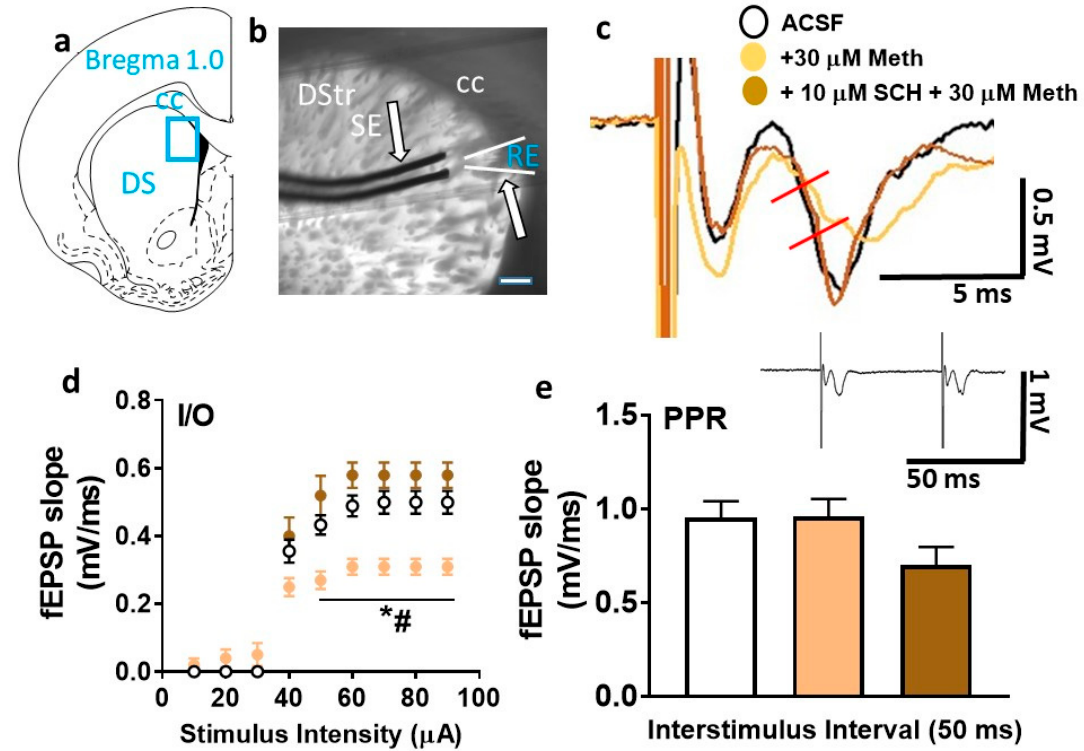
Figure 5. Basal synaptic transmission is reduced by superfusion of methamphetamine in the dorsal striatum. ( a ) Schematic of a coronal slice representing the area of the dorsomedial striatum in blue rectangular box used for stimulation and recordings. ( b ) Infrared microphotograph of a 440- µ m-thick corticostriatal slice from one adult male rat indicating the location of the stimulating electrode (SE) and recording electrode (RE). The scale bar in ( b ) is 100 µ m. Thick arrows point to the electrodes. CC: corpus callosum; DStr: dorsal striatum. ( c ) A representative field excitatory postsynaptic potential (fEPSP) waveform illustrating the parameter computed in the study, including fEPSP slope (measured between the two red lines) from control- (black trace), methamphetamine- (beige trace), and SCH23390 + methamphetamine-treated (brown trace) slices. ( d ) Input / output (I / O) curve obtained by plotting the slope of fEPSPs as a function of the stimulation intensity (from 10 to 90 µ A) in the dorsomedial striatum. ( e ) Paired-pulse ratio (PPR) from each slice is averaged from at least six traces with interstimulus interval at 50 ms. Inset shows an example trace used to calculate PPR. Data are represented as mean ± SEM. n = 9 control slices, n = 10 methamphetamine slices, and n = 5 SCH23390 + methamphetamine slices. * p < 0.05 vs. controls; # p < 0.05 vs. SCH23390 + methamphetamine by Fisher’s least